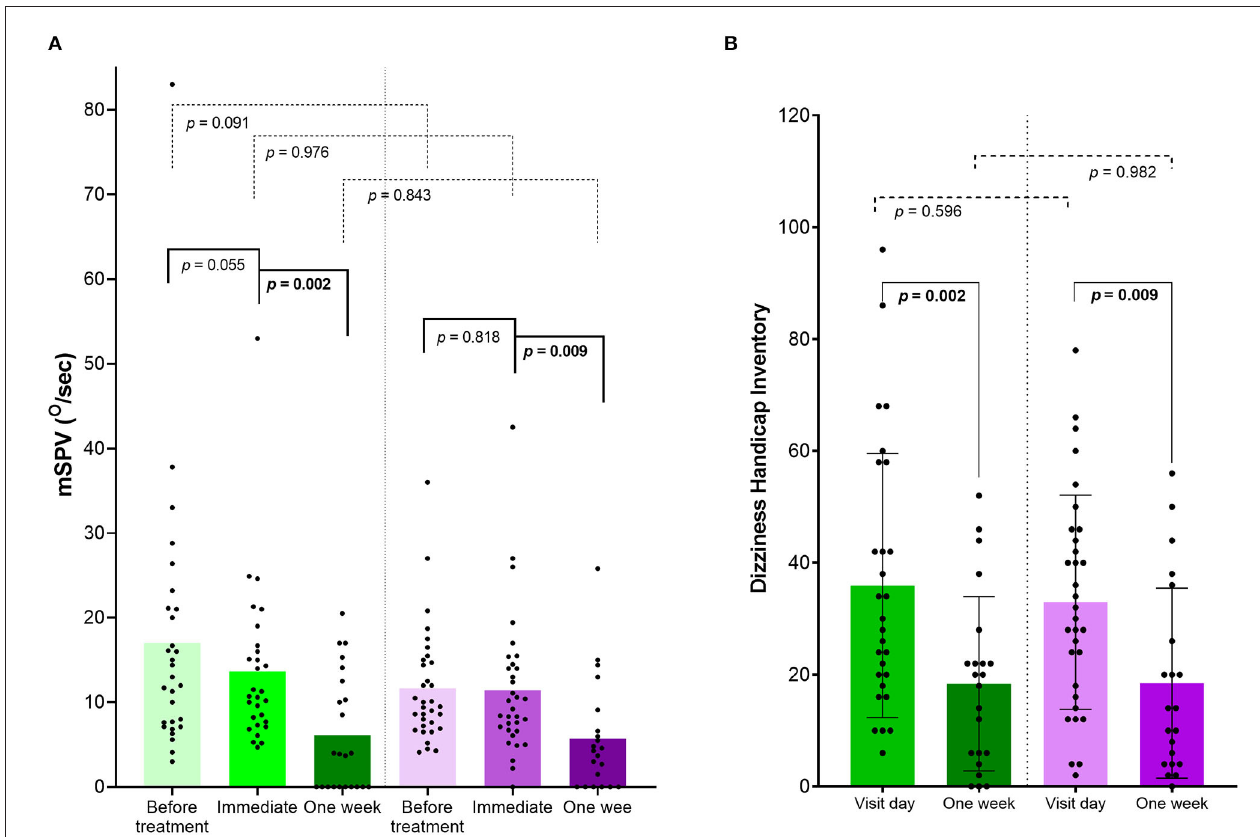
FIGURE 3 | The change of maximal slow phase velocity (mSPV) of positional nystagmus (A) and dizziness handicap inventory (DHI) (B) by application of Epley maneuver and Brandt-Daroff exercise immediately and at 1 week. The mSPV does not decrease by application of both Epley maneuver (green, 17.0 ± 15.4 ◦ /s vs. 13.6 ± 9.5 ◦ /s, p = 0.055) and Brandt-Daroff exercise (purple, 11.6 ± 6.8 ◦ /s vs. 11.4 ± 8.2 ◦ /s, p = 0.818) on the visit day, but decreases at 1 week (6.1 ± 7.0 ◦ /s, p = 0.002 and 5.7 ± 6.6 ◦ /s, p = 0.009). There is no significant difference between two maneuvers before ( p = 0.091), immediately ( p = 0.976), as well as at 1 week ( p = 0.843). The DHI significantly decreases at 1 week in both Epley maneuver (green, 35.9 ± 23.6 vs. 18.4 ± 15.6, p = 0.002) and Brandt-Daroff exercise groups (purple, 32.9 ± 19.1 vs. 18.5 ± 17.0, p = 0.009). There is no difference between two maneuvers on the visit day ( p = 0.596) and at 1 week ( p = 0.982). mSPV, maximal slow phase velocity of positional